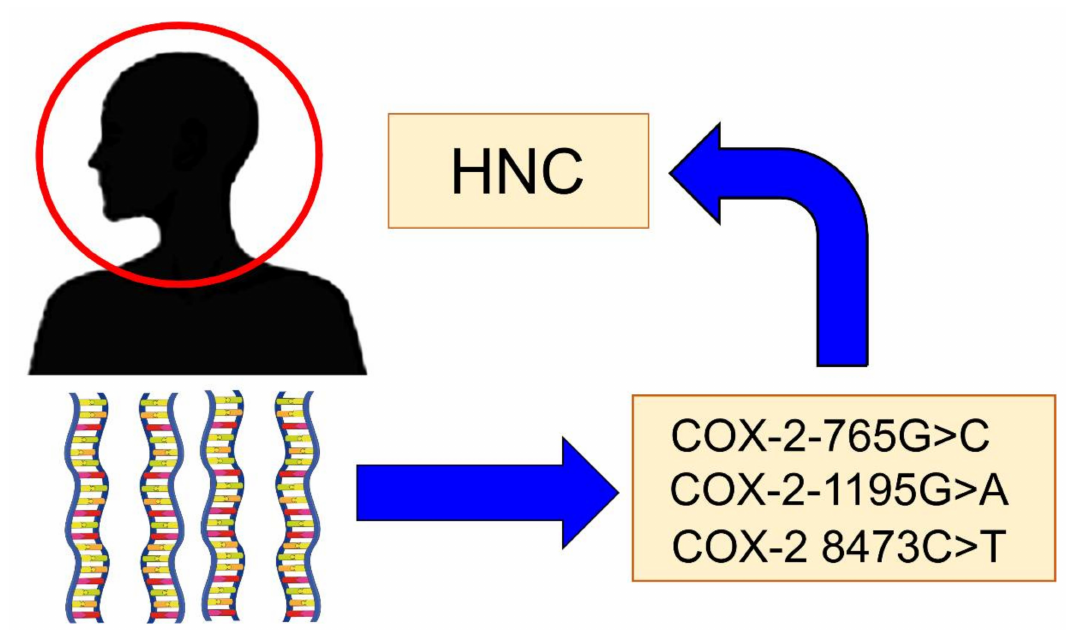
Figure 2. The main Cyclooxygenase-2 (COX-2) polymorphisms are implicated in the risk of head and neck cancer